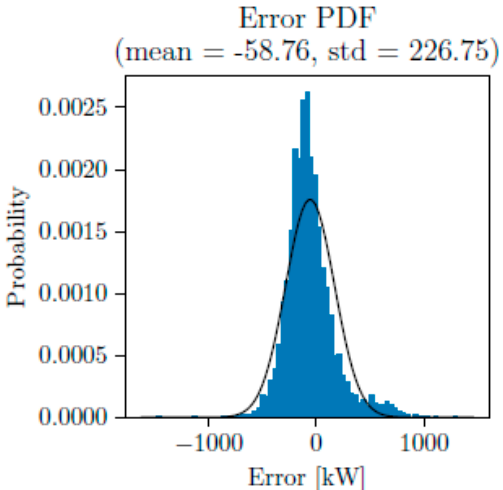
Figure 11. Ten-minutes-ahead error distribution.